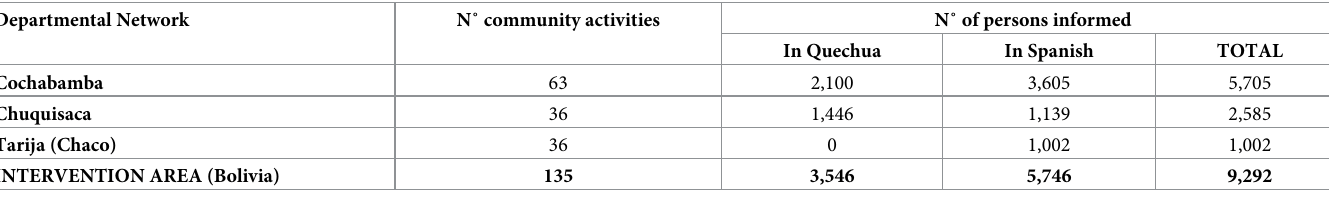
Table 4. Community based activities performed in the context of Chagas network